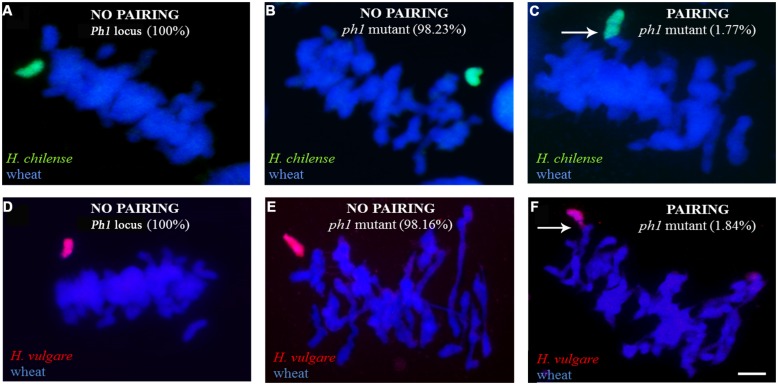
Chromosome pairing at meiotic metaphase I as determined by the allelic status at Ph1. In the presence of Ph1, the Hordeum sp. chromosomes [(A) 7Hch, shown in green and (D) 4Hv, shown in red] remained unpaired. In a ph1b background, the Hordeum sp. chromosome [(B) 5Hch, shown in green and (E) 7Hv, shown in red] remained as a univalent in most cells. Allosyndesis is induced by the absence of Ph1 between a Hordeum sp. chromosome [(C) 5Hch, shown in green and (F) 7Hv, shown in red], and a wheat chromosome. Arrows indicate pairing between Hordeum sp.-wheat homoeologs induced by the absence of the Ph1 locus. Bar: 10 μm.